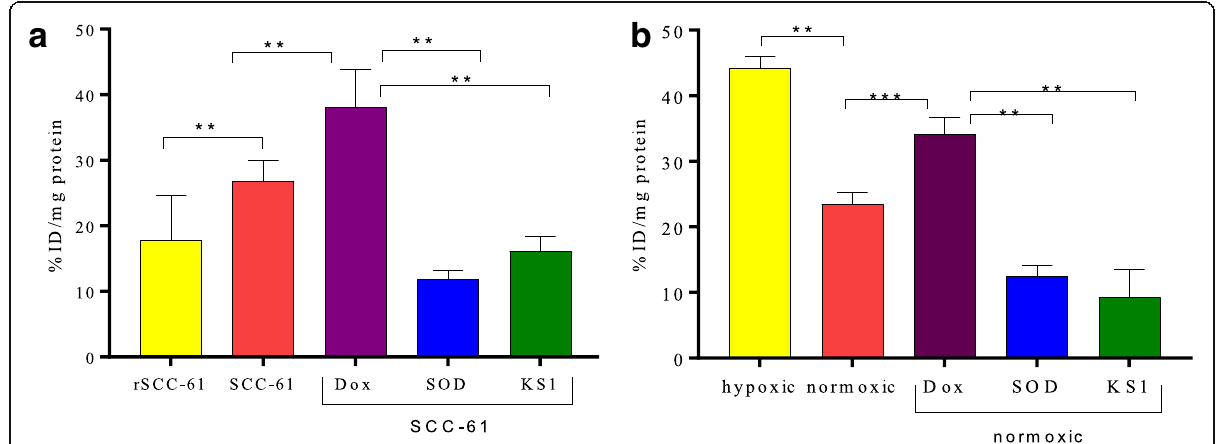
Fig. 4 Cell uptake of 18 F-KS1 at baseline, promoter, and blockade conditions ( n = 6) after 60 min in vitro in ( a ) SCC-61 and rSCC-61 and ( b ) in PC3 cell line under normoxic and hypoxic conditions after 60 min. The data were expressed as % injected dose (ID)/mg of protein present in each well, with ** p ≤ 0.05 considered statistically significant. Plates without ligands are controls